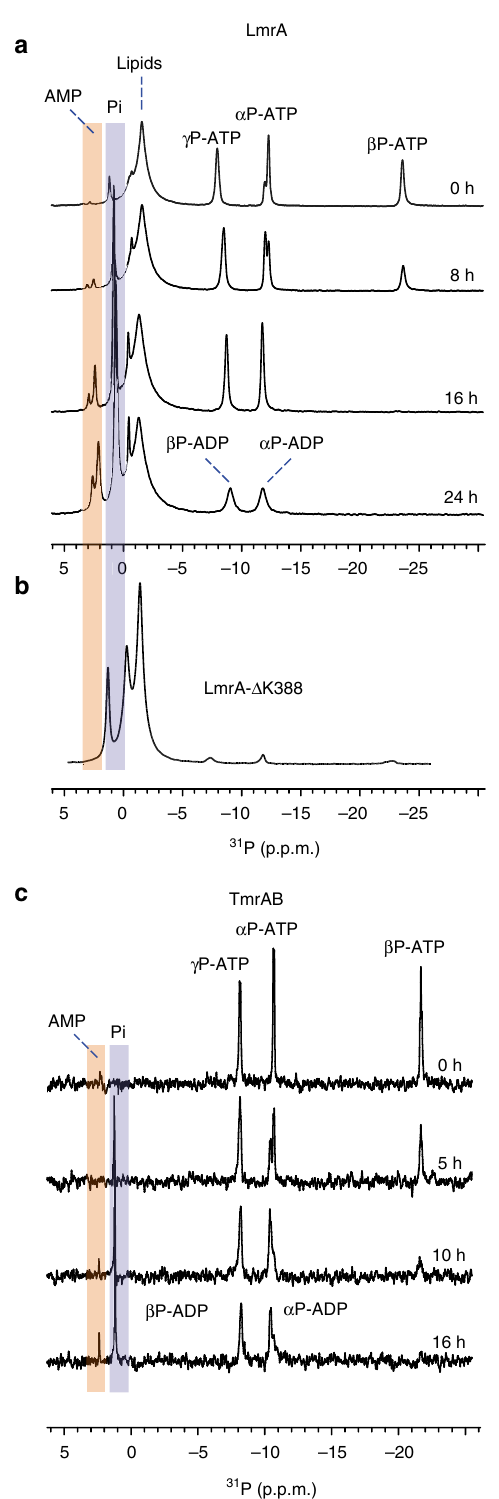
Figure 7 | Time-resolved 31 P-NMR spectra of LmrA and TmrAB in the presence of ATP reveal AMP formation as observed for